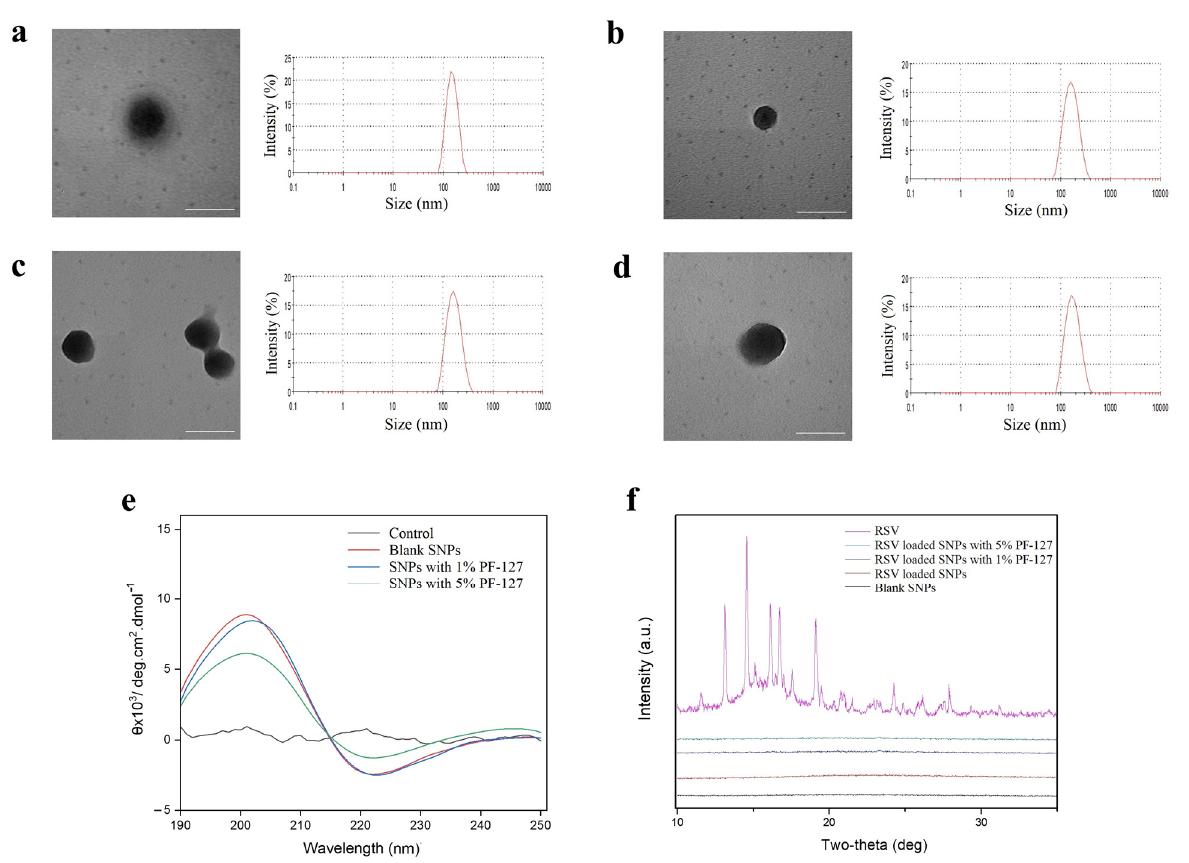
Figure 1. Physicochemical characterization of NPs. Representative TEM images and the corresponding size distribution profiles of ( a ) blank NPs, ( b ) RSV-NPs, ( c ) PF-127-RSV-NPs (1%), and ( d ) PF-127-RSV-NPs (5%). Scale bar represents 200 nm. ( e ) CD spectra and ( f ) XRD patterns of pure resveratrol, blank silk fibroin-based NPs, PF-127-RSV-NPs (1%), and PF-127-RSV-NPs